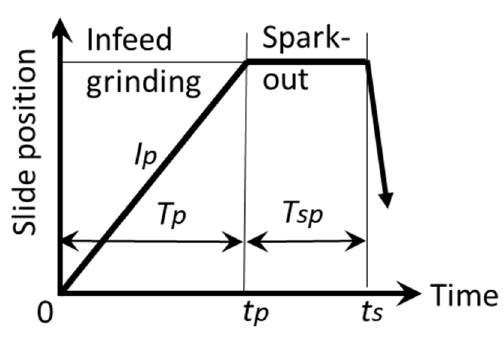
Figure 17. Primary grinding cycle.